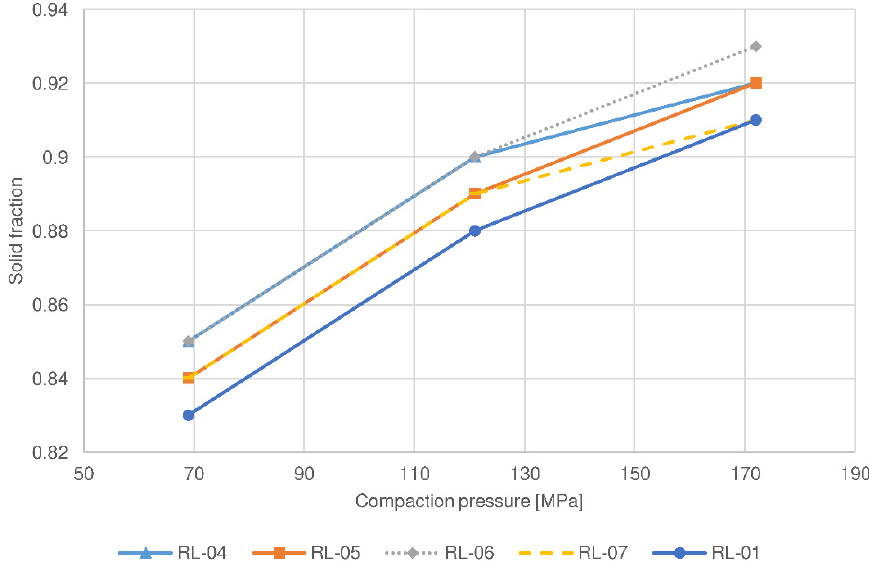
Figure 3. Compressibility plot of selected compression mixtures containing lactose as a filler.